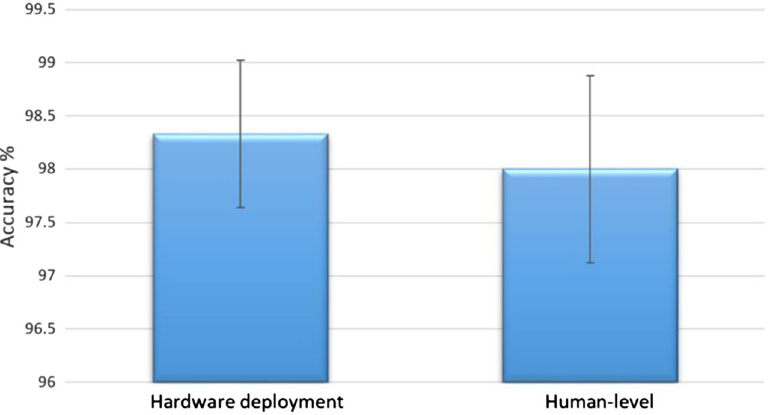
Figure 7. Model deployment and human-level performance accuracy as a percentage (%) of total mosquitoes used for prediction; there was no significant difference between the accuracy of hardware and human-level performance t (58) = 0.297, p = 0.768, by the independent-samples t-tests in SPSS 17.0.